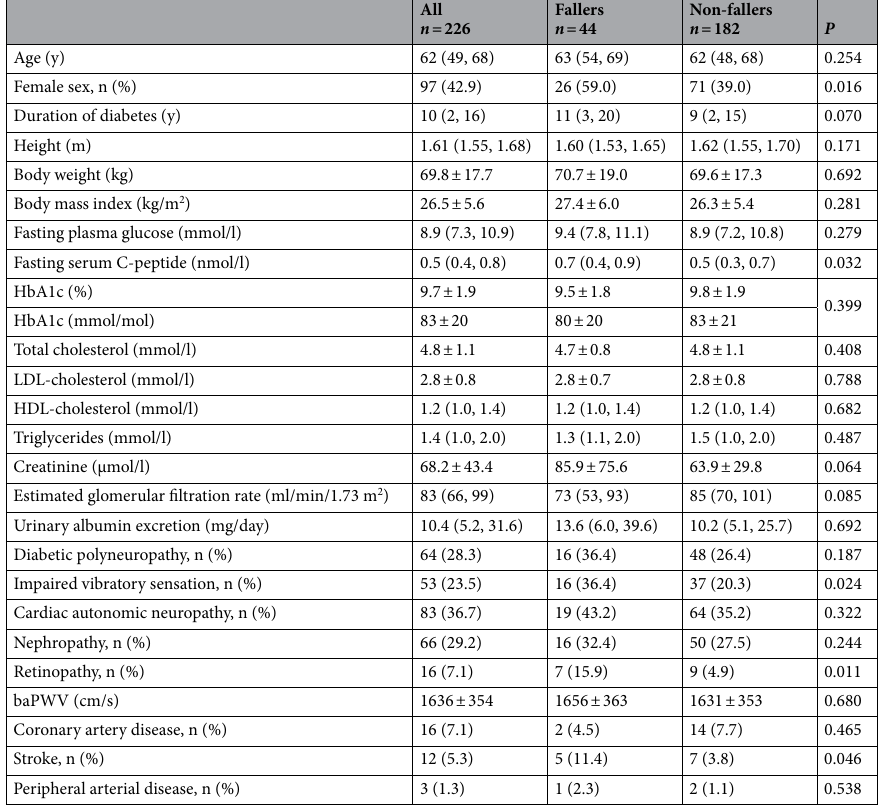
Table 1. Characteristics of participants. Data are mean ± SD or median (25th, 75th). LDL, low-density lipoprotein; HDL, high-density lipoprotein; baPWV, brachial-ankle pulse wave